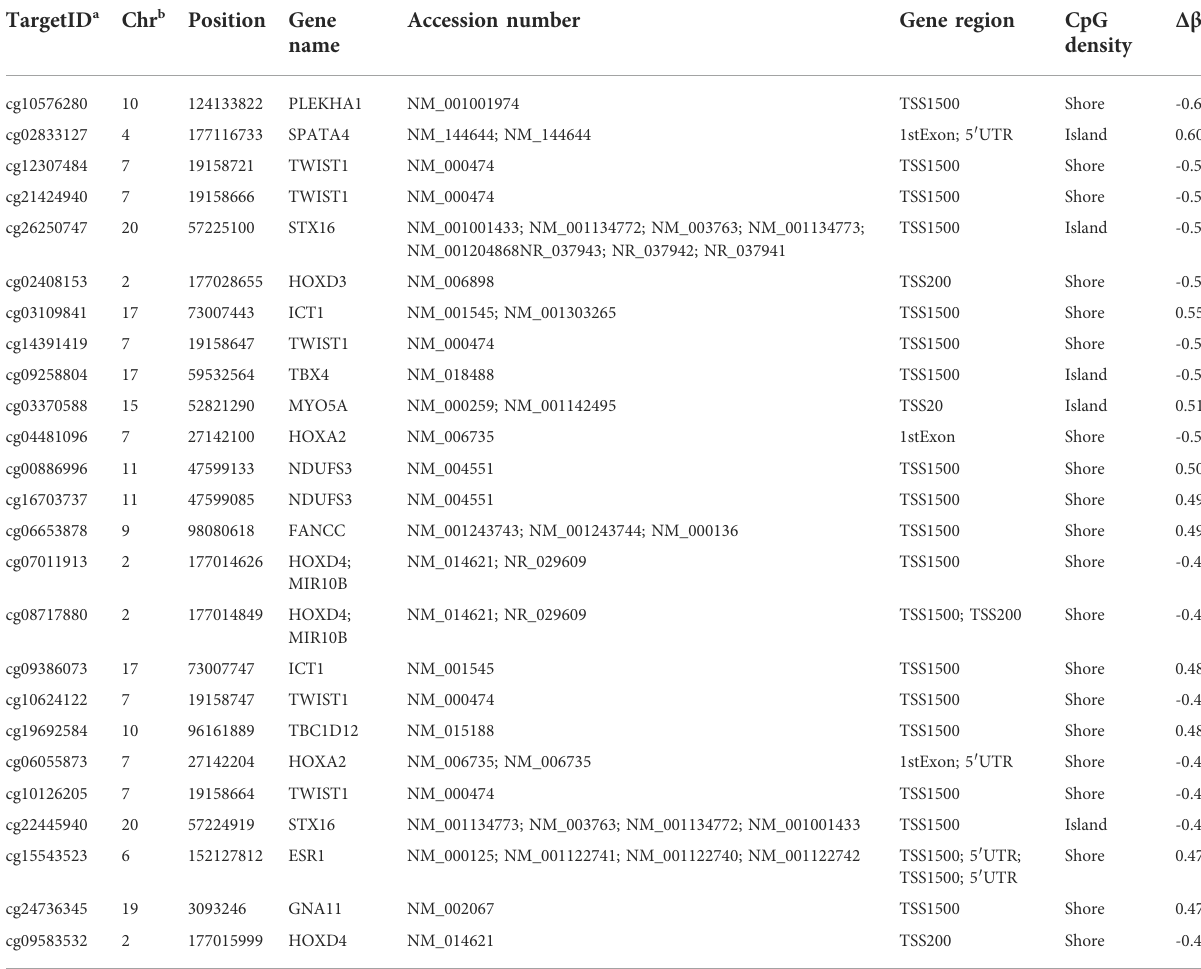
TABLE 2 Top 25 signi fi cant differentially methylated CpGs from promoter CGIs/shore regions belonging to the epigenetic signature that differentiates the ITF of paired tumors in uADC patients. TargetID a Chr b Position